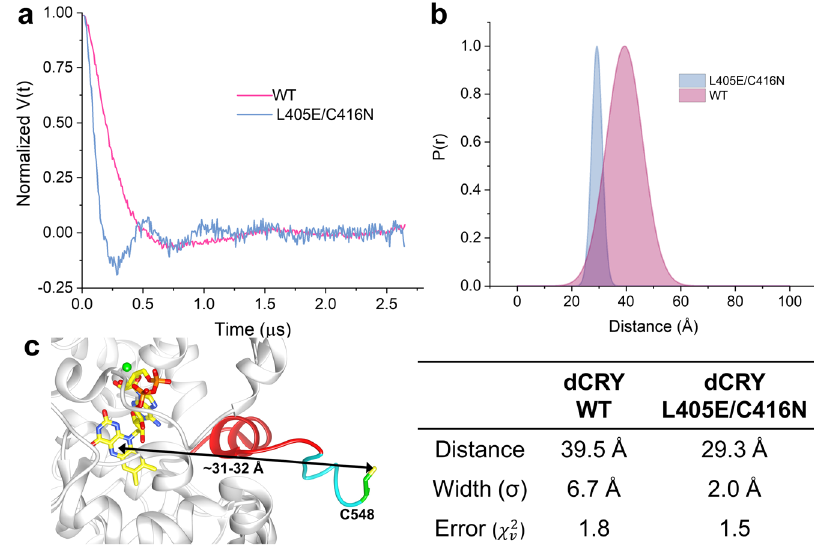
Fig. 4 Flavin-nitroxide DEER spectroscopy of irradiated dCRY. 4P-DEER time-domain trace ( a ) and pulse dipolar distance distribution ( b ) obtained between active site fl avin and nitroxide radicals on CTT of dCRY variant. The distance distribution is shorter and narrower for the NSQ forming dCRY L405E/C416N (blue) variant when compared to the WT protein (pink) after light exposure. The error values ( χ 2 v ) for the distance reconstruction are close to 1, indicating a good fi t; the error bar on the distance values are below 0.2 Å. c The crystal structure of dCRY-WT-SORTC-SL in the dark state shows that the active site FAD and the sulfhydryl group on the GGGGC linker are separated by ~31 – 32 Å (depending on the FAD atom chosen). Magnesium atoms are shown as green